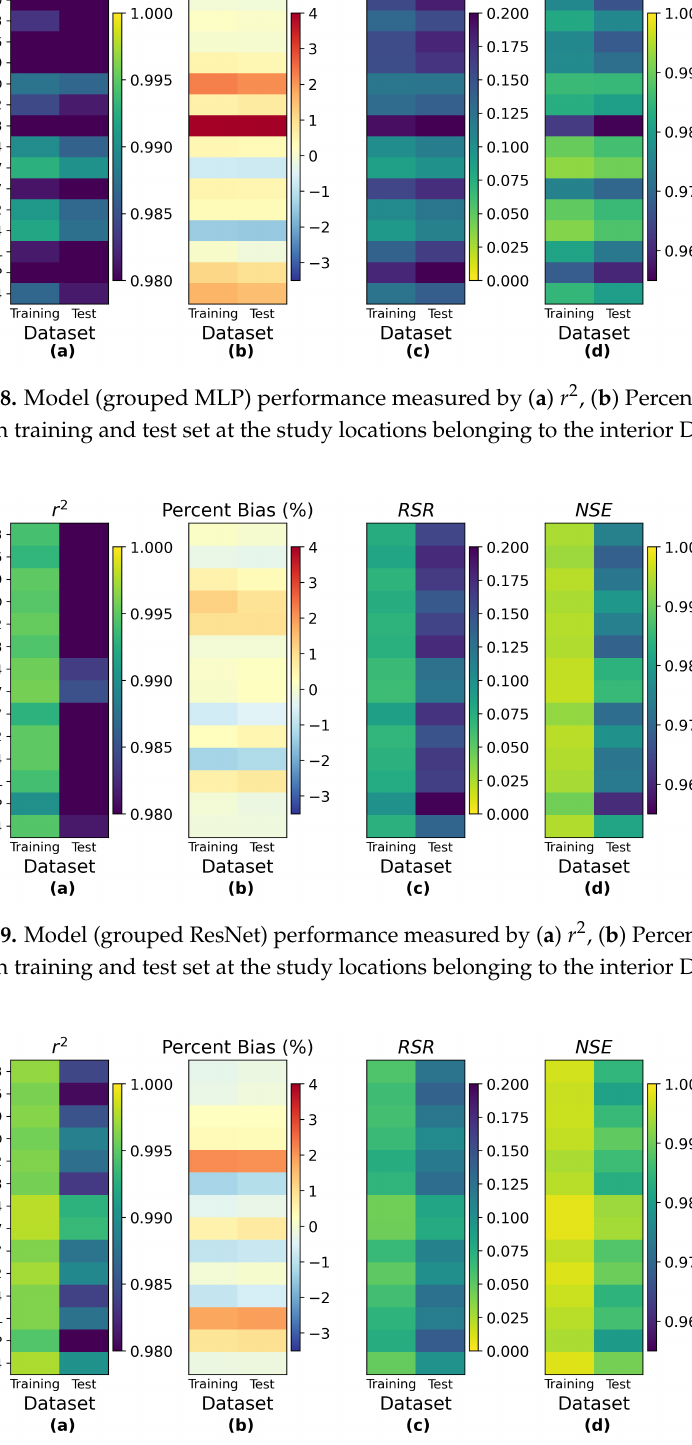
Figure A20. Model (grouped GRU) performance measured by ( a ) r 2 , ( b ) Percent Bias, ( c ) RSR, and ( d ) NSE on training and test set at the study locations belonging to the interior Delta